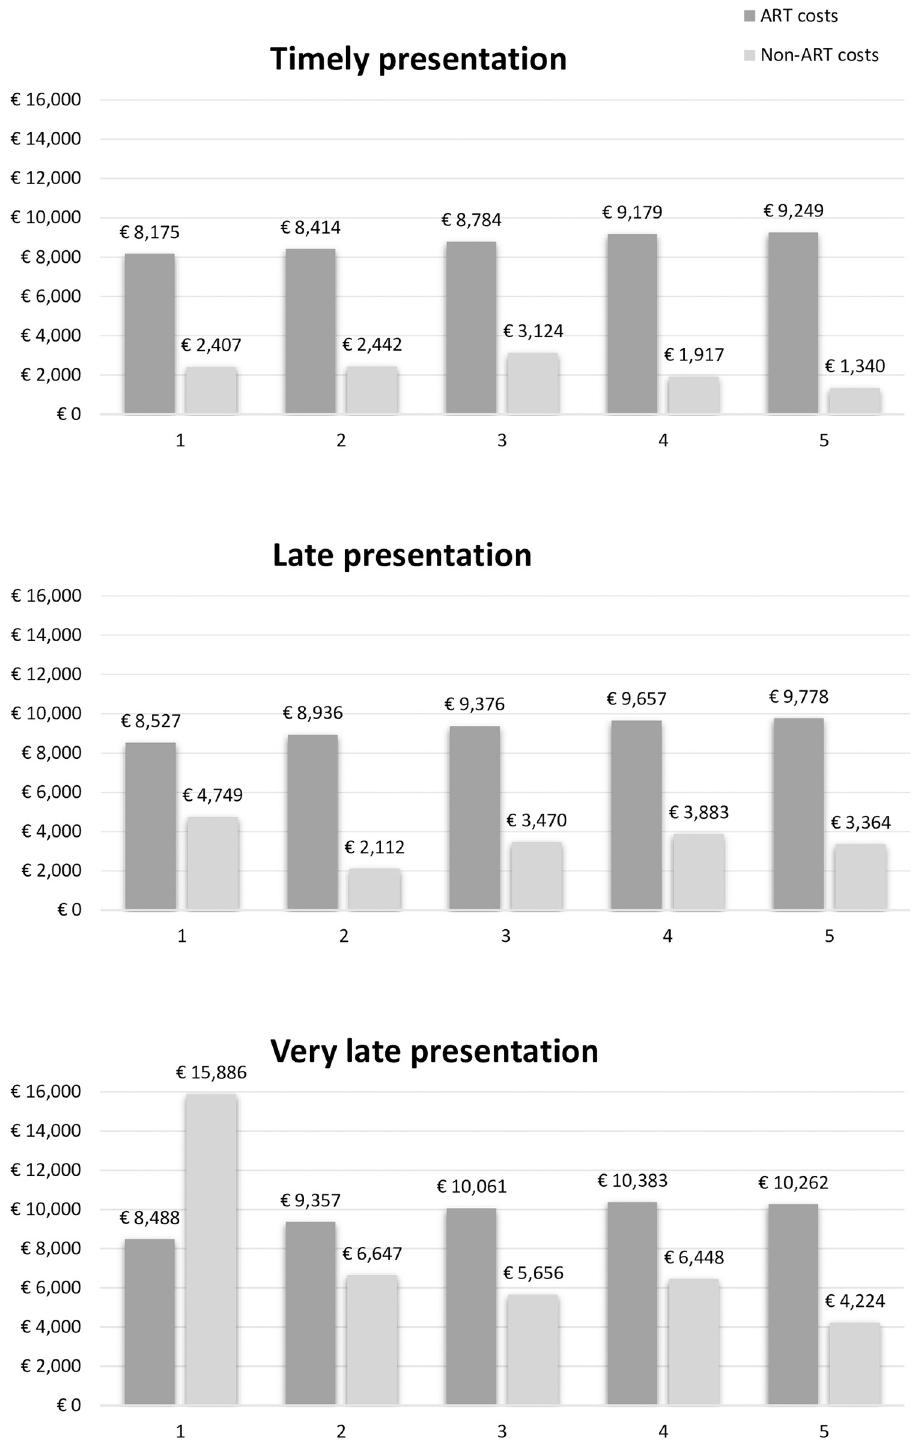
Fig 2. The mean HIV-care cost per individual divided by ART and non-ART related costs according to different stages of presentation for HIV-care. The y-axis represents the cost in € and the x-axis the years after ART initiation.